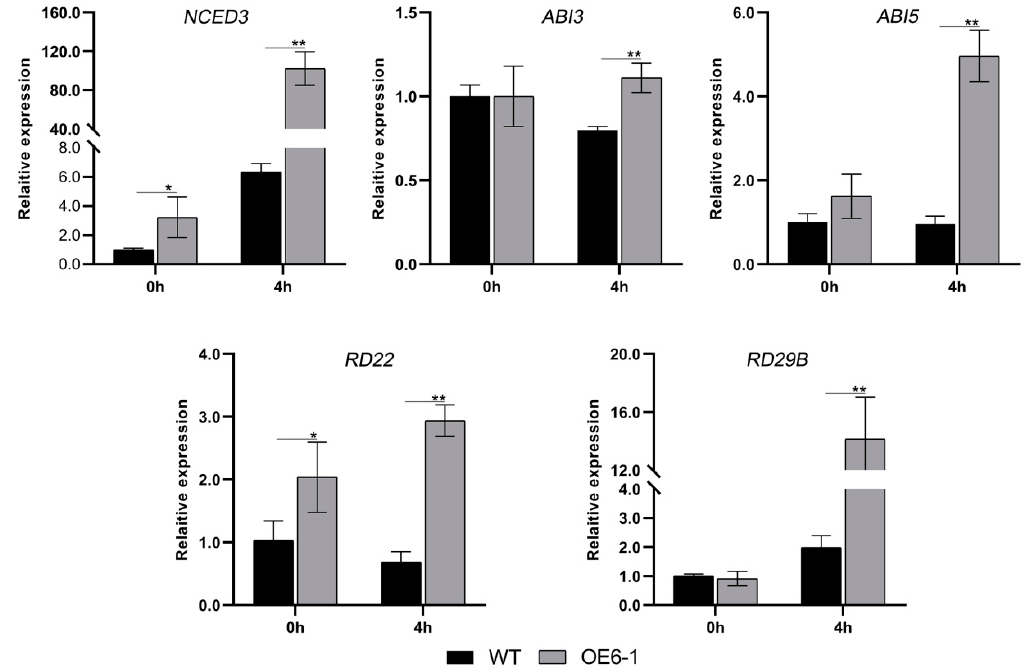
Figure 7. Expression patterns of ABA-related genes regulated by CbWRKY27 under salt treatment. 9-cis-epoxycarotenoid dioxygenase 3 (NCED3), abscisic acid insensitive 3 (ABI3), abscisic acid insensitive 5 (ABI5), responsive to dehydration 22 (RD22), and responsive to desiccation 29B (RD29B). qPCR data were normalized to the internal control expression of CbActin. The 2 −ΔΔ Ct method was used to evaluate quantitative variation between replicates. The data represent the means ± SD (n = 3), * p < 0.05 and ** p < 0.01 using Student’s t-test. The six-week-old seedlings were subjected to 300 mM NaCl treatment.